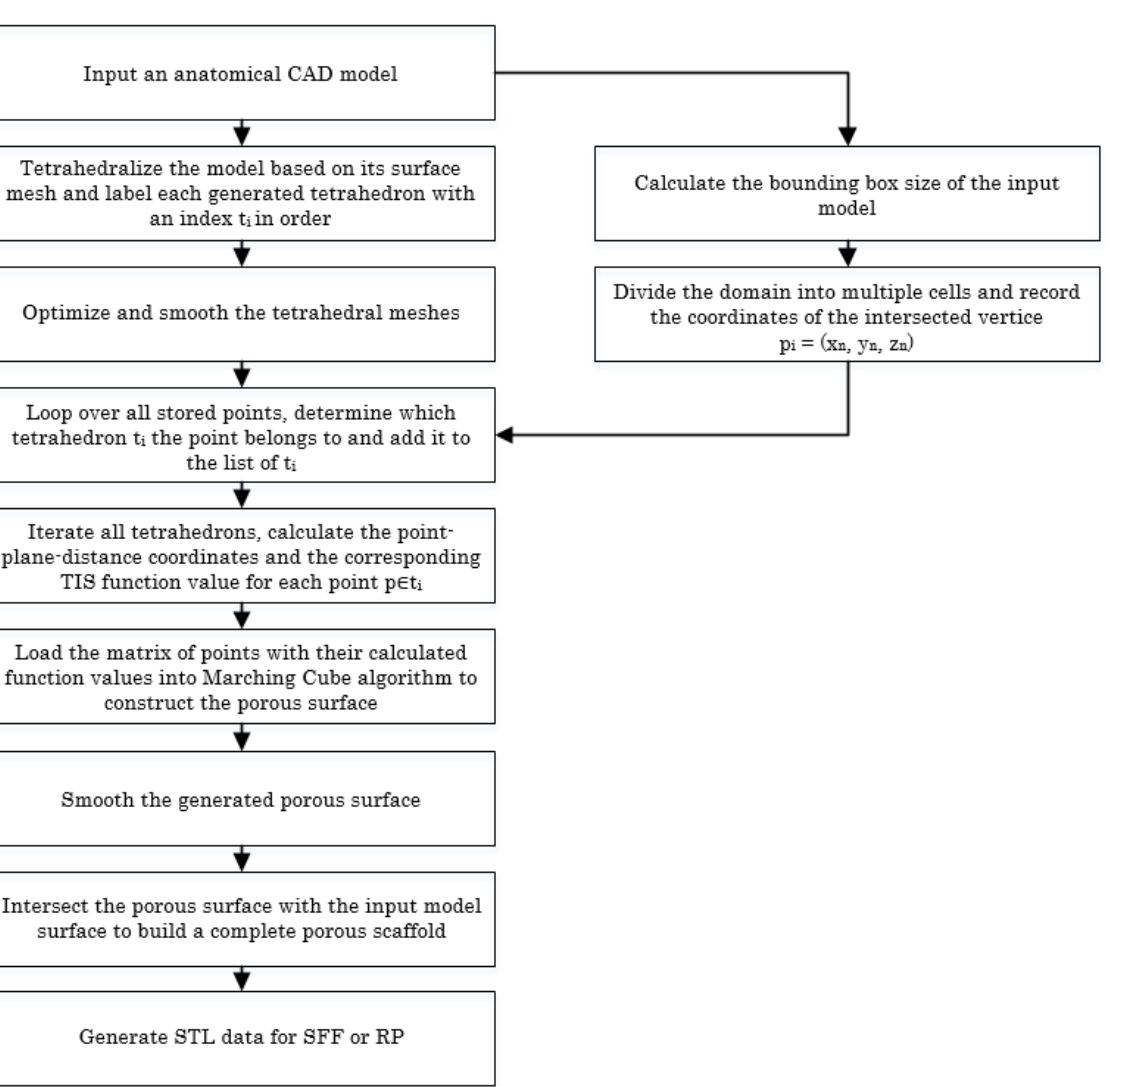
Figure 4. Flowchart showing the procedures for designing a 3D heterogeneous porous scaffold using the TIS